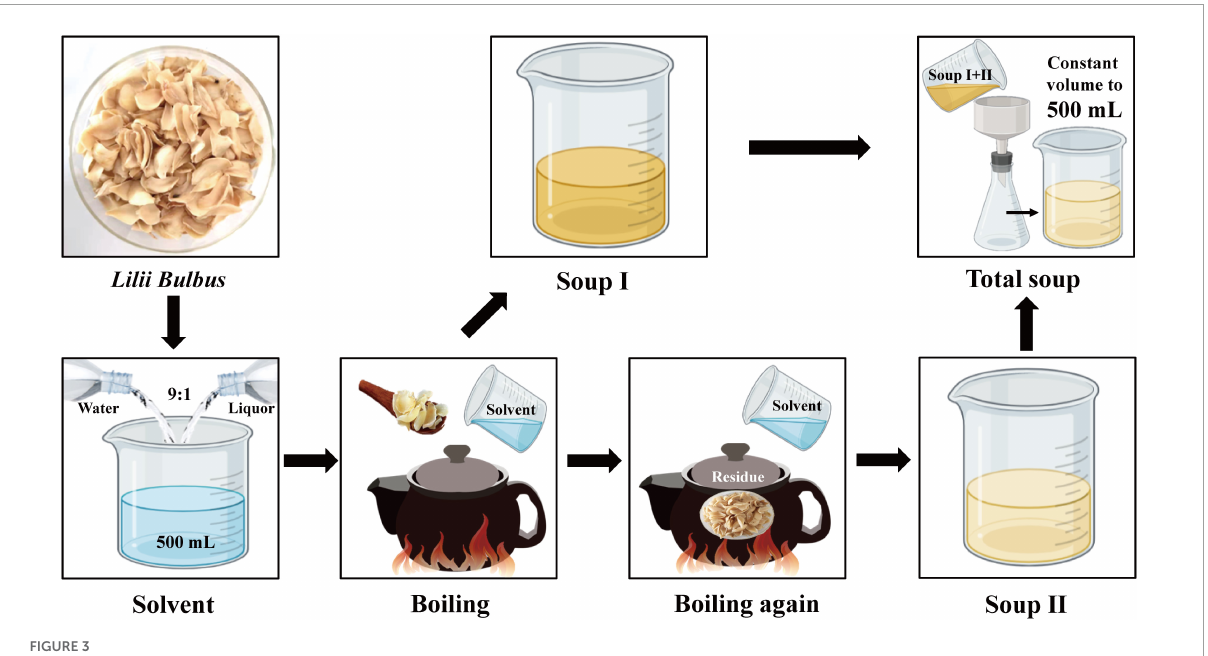
FIGURE3 The operation flowchart of process